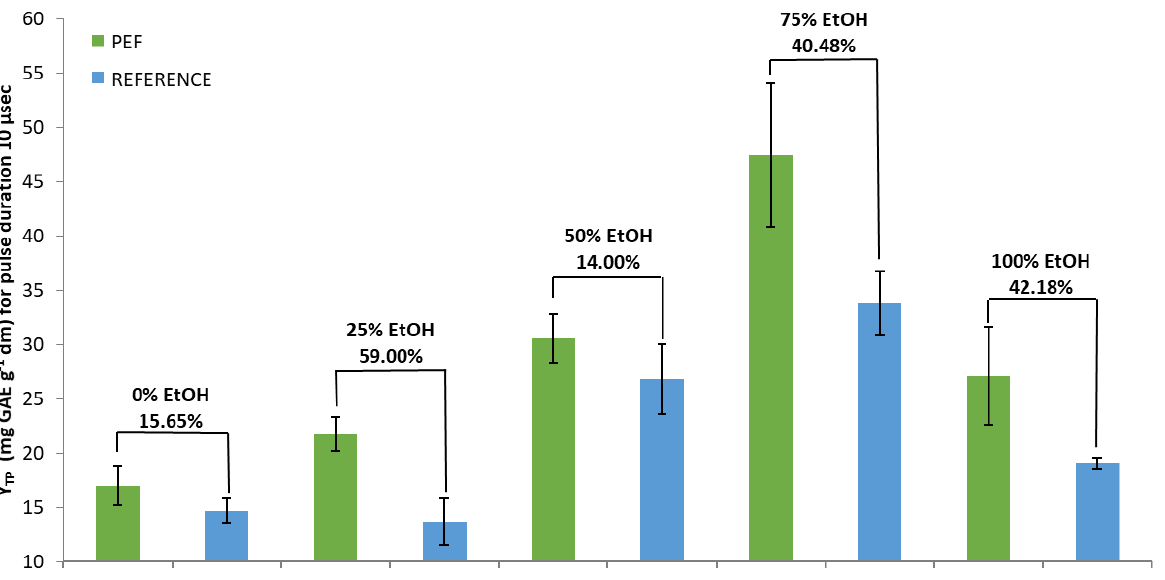
Figure 1. Y TP for PEF-treated and reference extracts in five different tested solvents and a pulse duration of 10 µ s. Y TP is the total polyphenol yield.